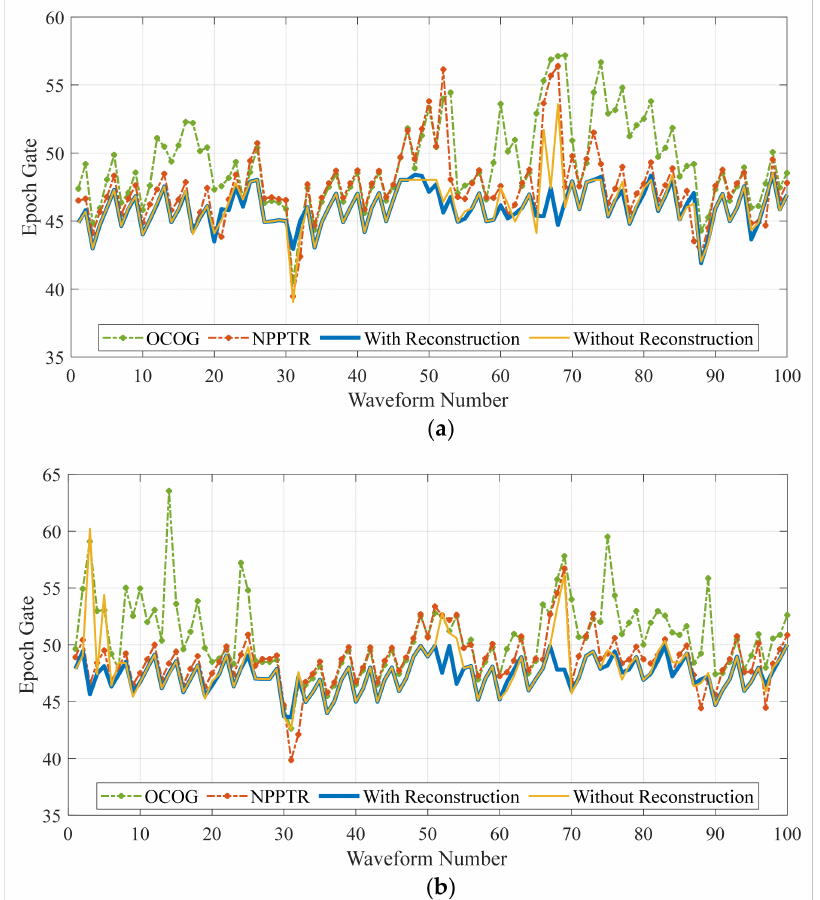
Figure 13. Epoch-retracking results for experimental area 2 in ( a ) March and ( b ) August. The green and red dotted lines represent the OCOG retracking results and the NPPTR results, and the blue and yellow solid lines represent the retracking results of the reconstructed and original waveforms.